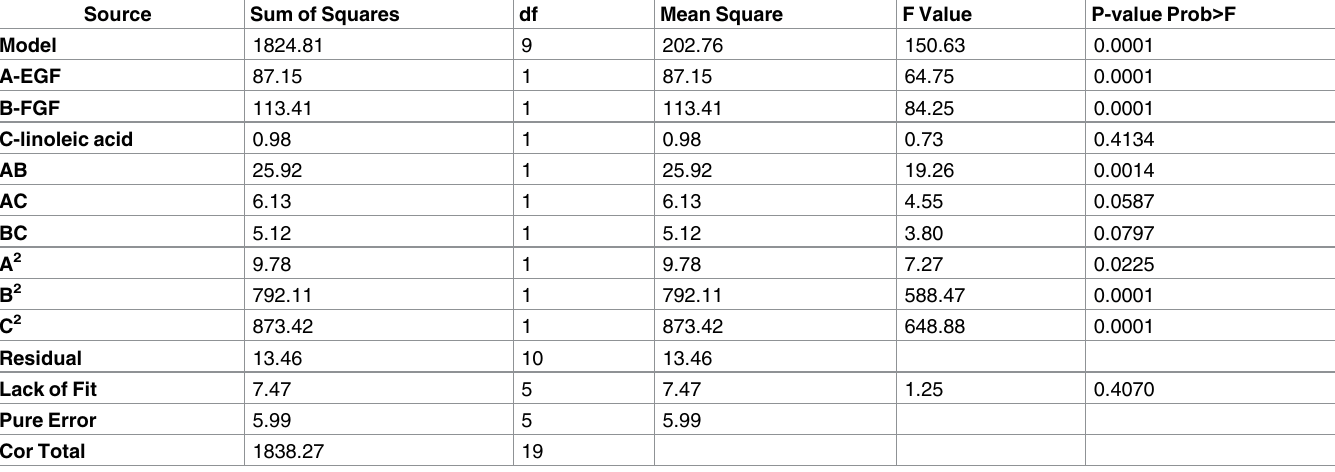
Table 5. ANOVA for central composite design of response